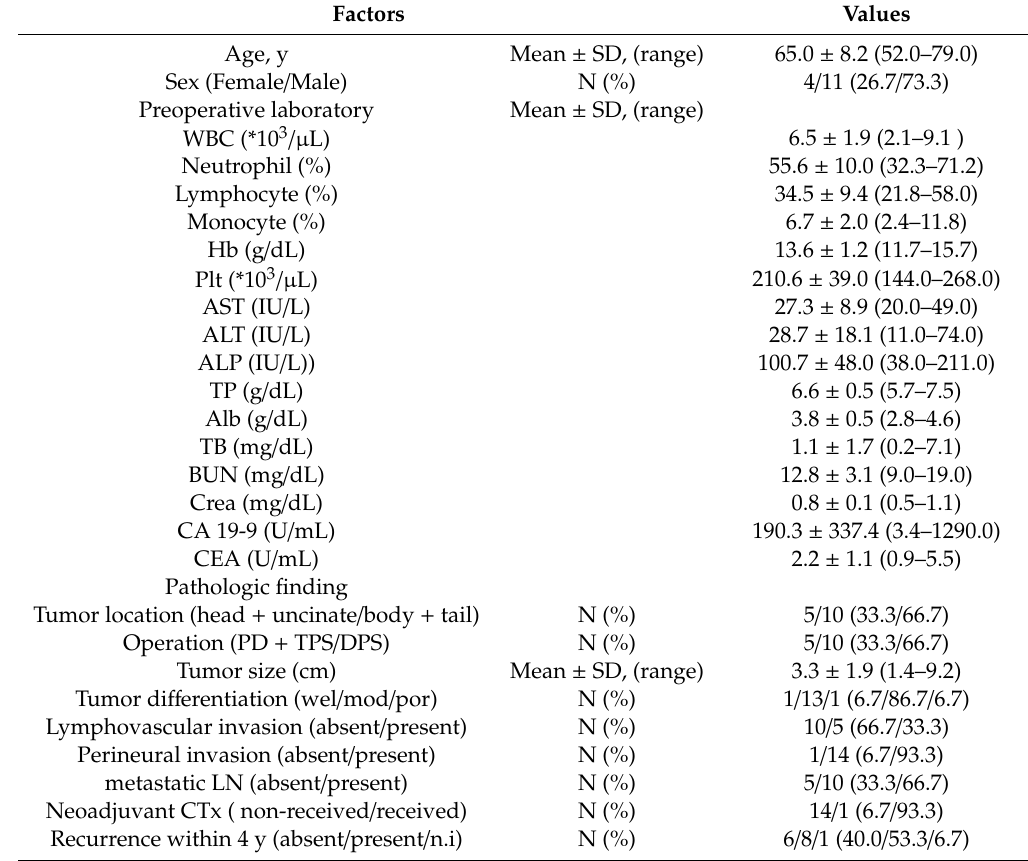
Table1. Clinicalandtissuecharacteristicsofenrolledpatients.SD;standarddeviation, WBC;whiteblood cell, Hb; hemoglobin, Plt; platelet, AST; aspartate aminotransferase, ALT; alanine aminotransferase, ALP; alkaline phosphatase, TP; total protein, Alb; albumin, TB; total bilirubin, BUN; blood urea nitrogen, Crea; creatinine, CA 19–9; carbohydrate antigen 19–9, CEA; carcinoembryonic antigen, PD; pancreaticoduodenectomy, TPS; total pancreatectomy with splenectomy, DPS; distal pancreatectomy with splenectomy, LN; lymph node, CTx; chemotherapy, n.i.; not